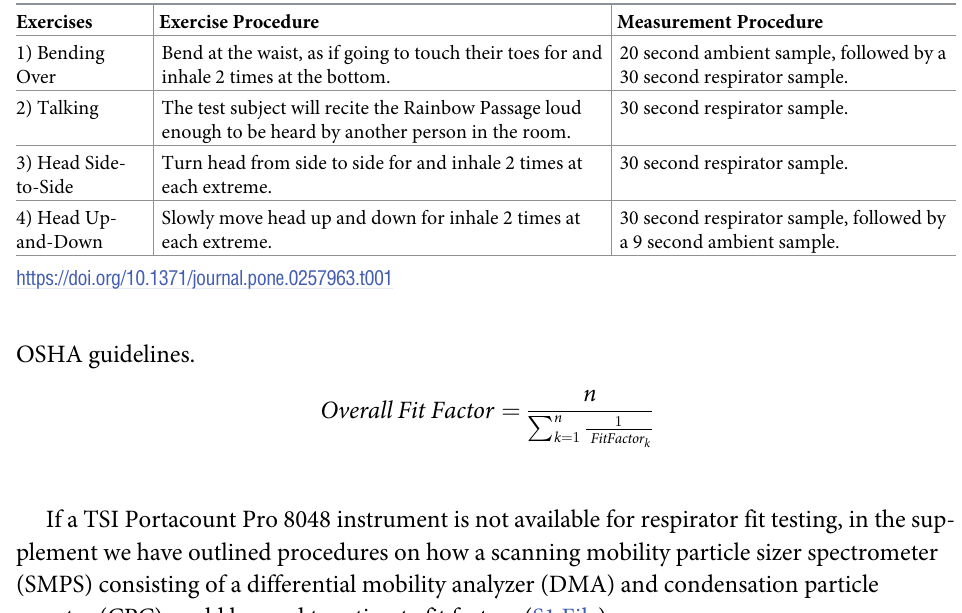
Table 1. Description of OSHA guidelines on quantitative respirator fit testing procedures